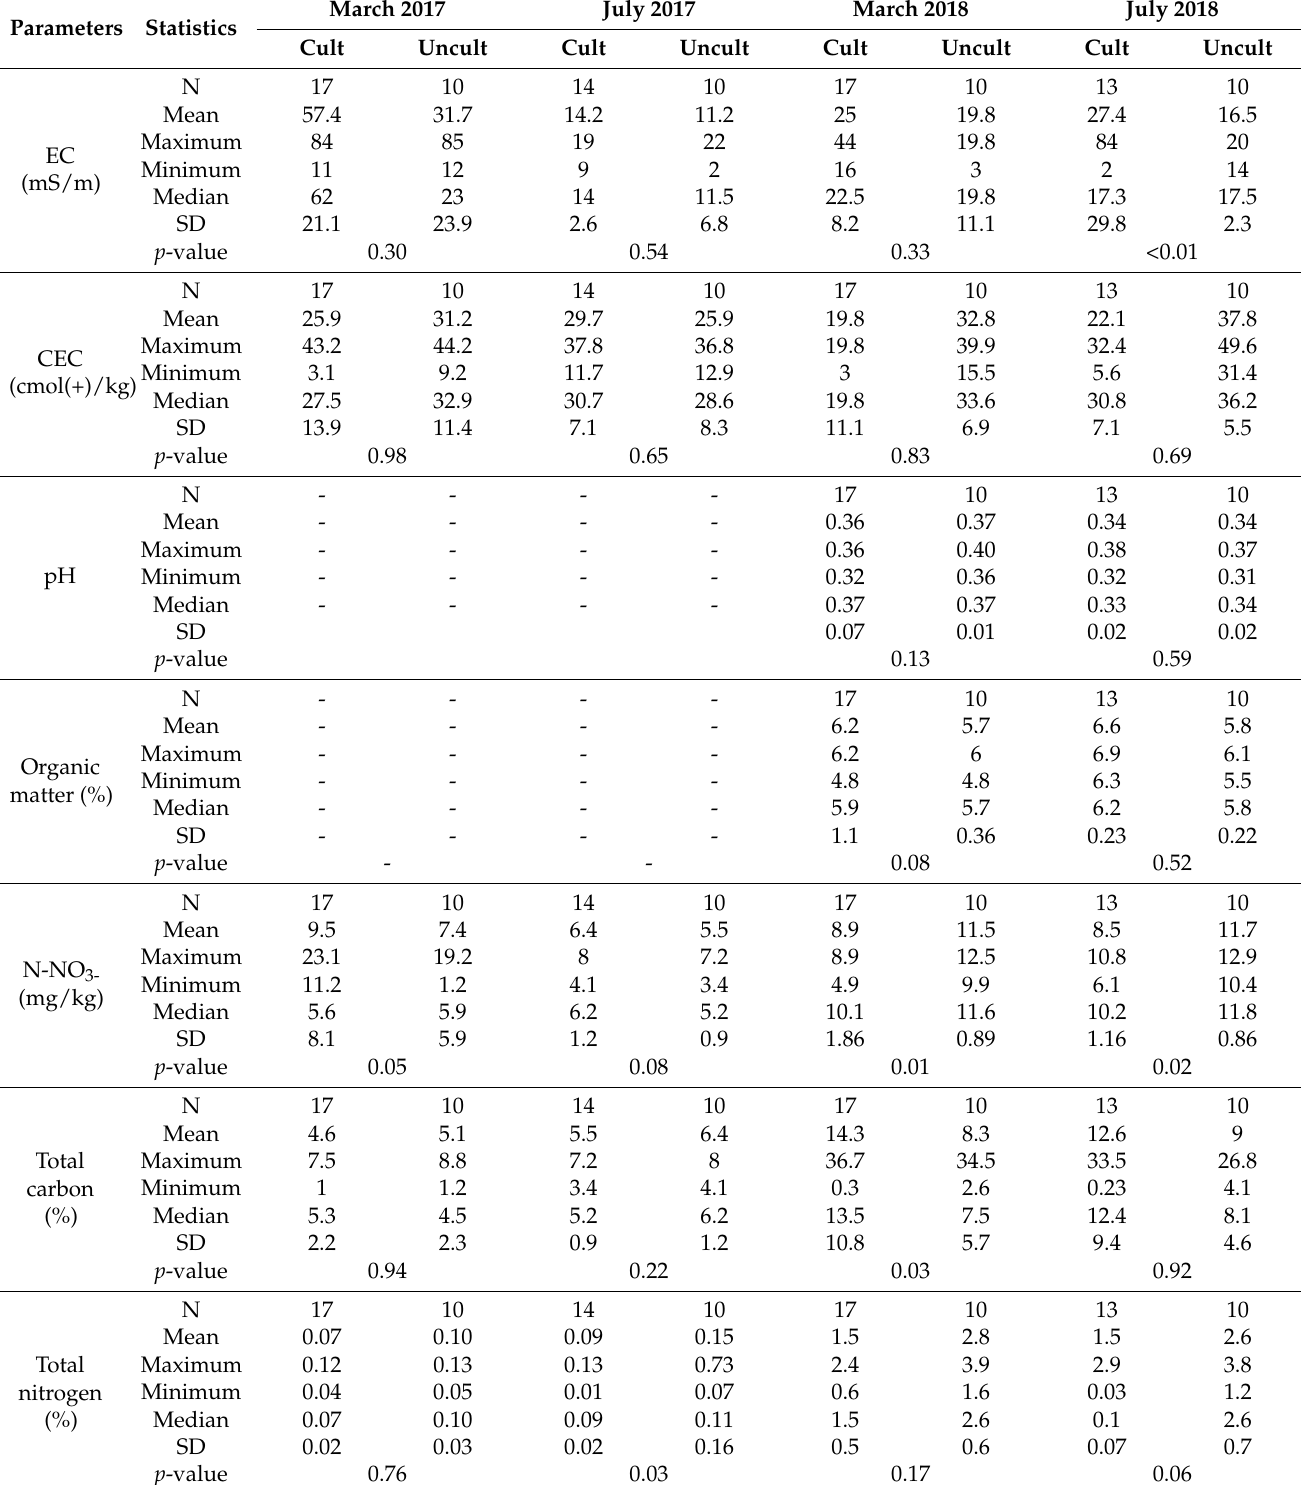
Table 3. Soil physico-chemical properties of cultivated and uncultivated